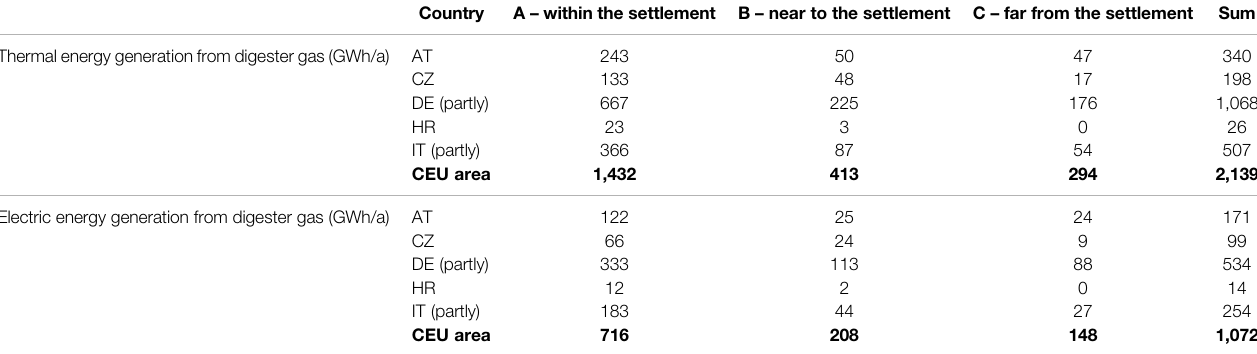
TABLE 8 | Estimation of thermal and electric energy generation from digester gas (in GWh/a) in context to the adjacent settlement structures (own illustration). Country